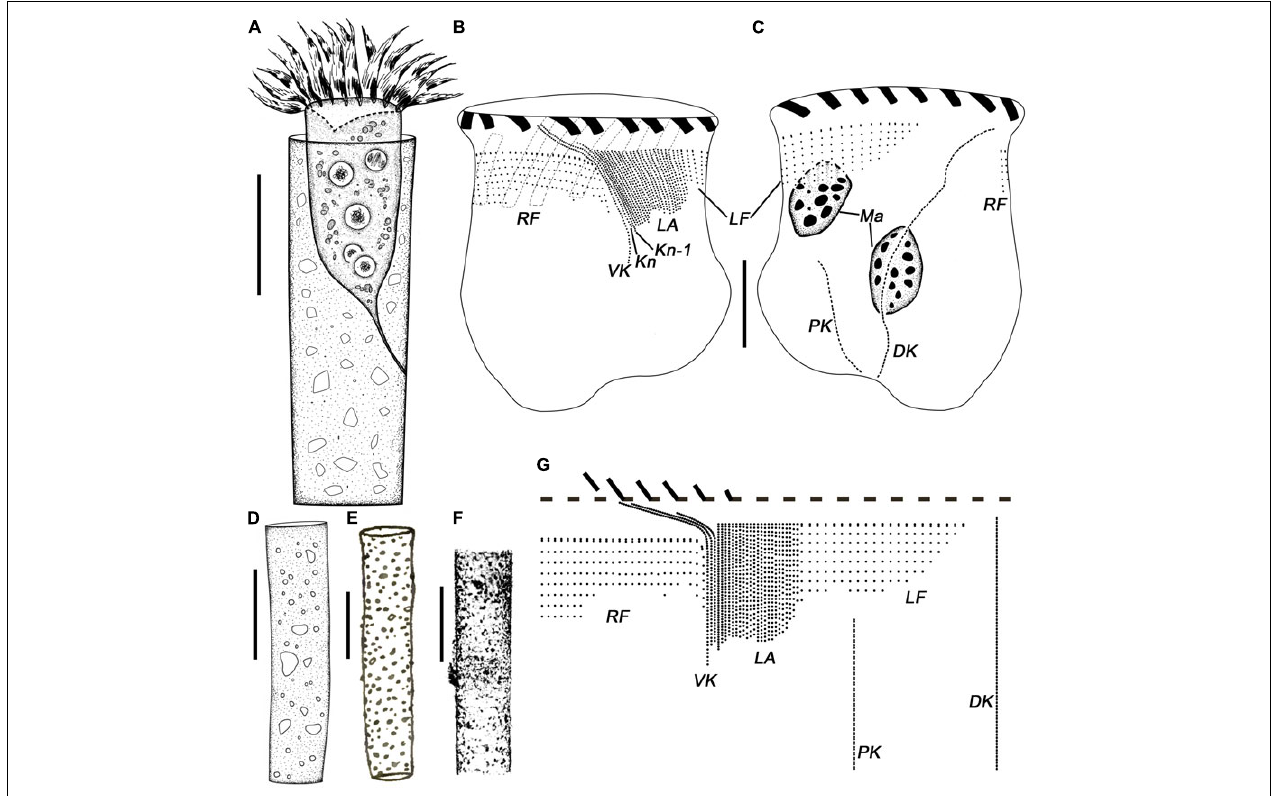
FIGURE 5 | Leprotintinnus simplex from life (A,D–F) and after protargol staining (B,C,G) . (A) Lateral view of a typical individual. (B,C) The ciliary pattern of ventral and dorsal sides of the same specimen. (D) Loricae with agglomerated mineral particles. (E) Lateral view of loricae from Schmidt, 1902. (F) L. neriticus from Yoo et al., 1988. (G) Kinetal map of a morphostatic specimen. DK, dorsal kinety; K n , the last kinety of the lateral ciliary field; K n - 1 , the penultimate kinety of the lateral ciliary field; LA, lateral ciliary field; LF, left ciliary field; Ma, macronuclear nodules; RF, right ciliary field; VK, ventral kinety. Scale bars: 40 µ m (A,D–F) , 20 µ m (B,C) .